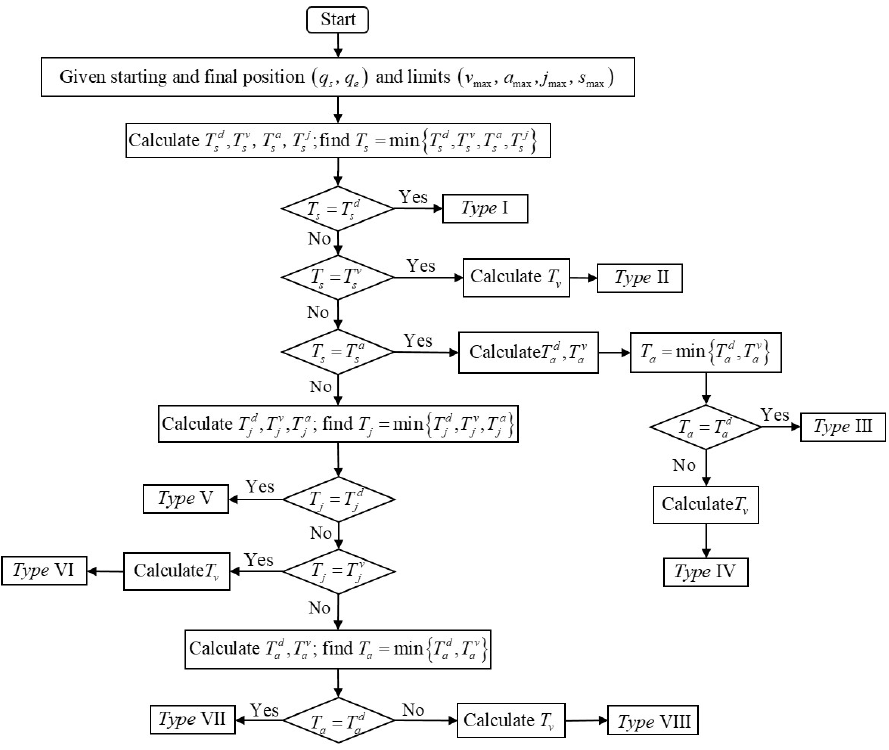
Figure 5. Flowchart of the proposed S-curve trajectory planning